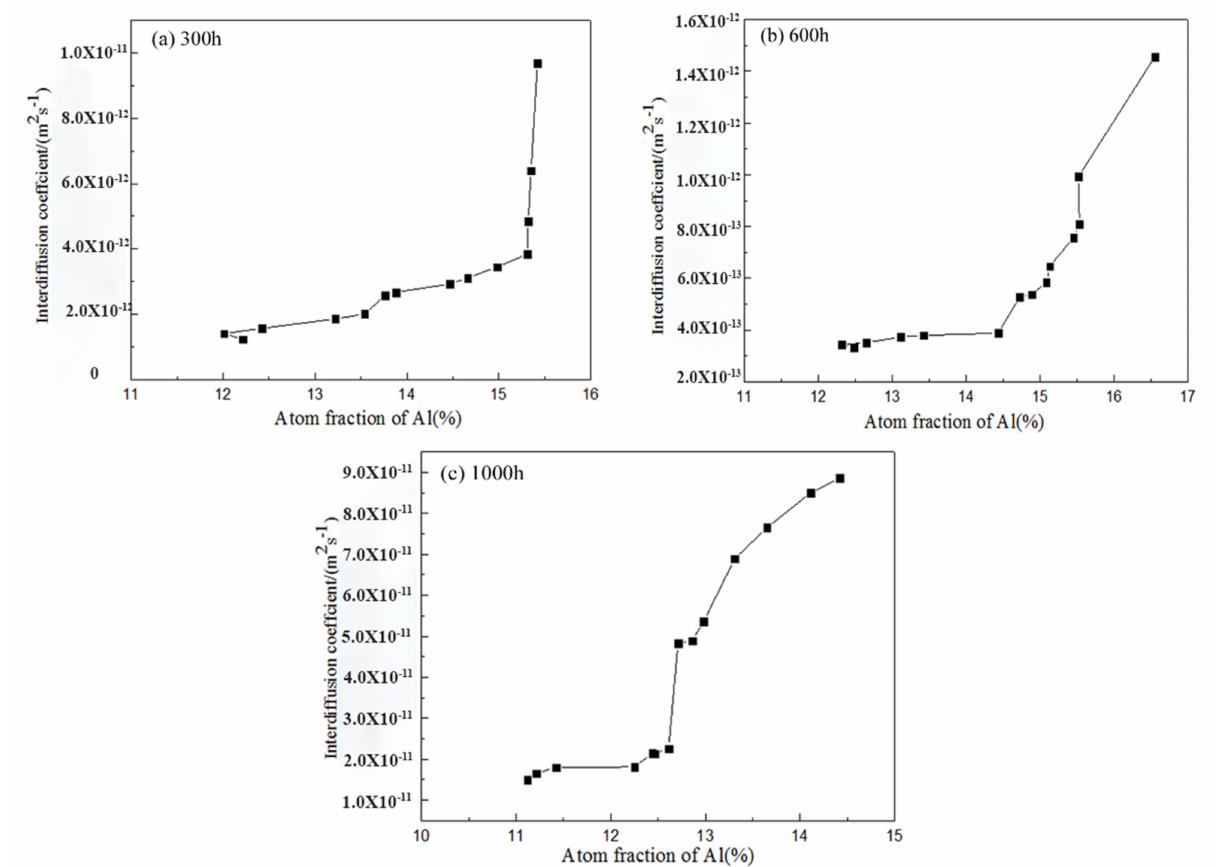
Figure 9. Various times of interdiffusion coefficients for aluminum with a variety of atomic contents: ( a ) 300 h; ( b ) 600 h; ( c ) 1000